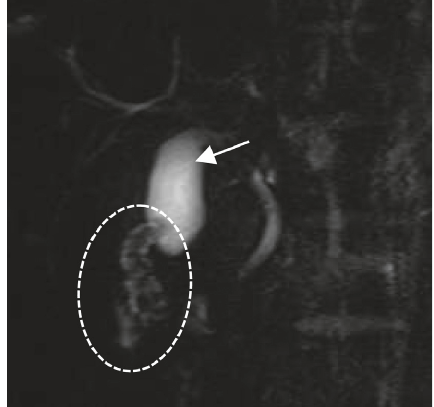
a pearl necklace sign (circle), continuous with the proximal gall- bladder (arrow), and no other anomalies (e.g., pancreaticobiliary